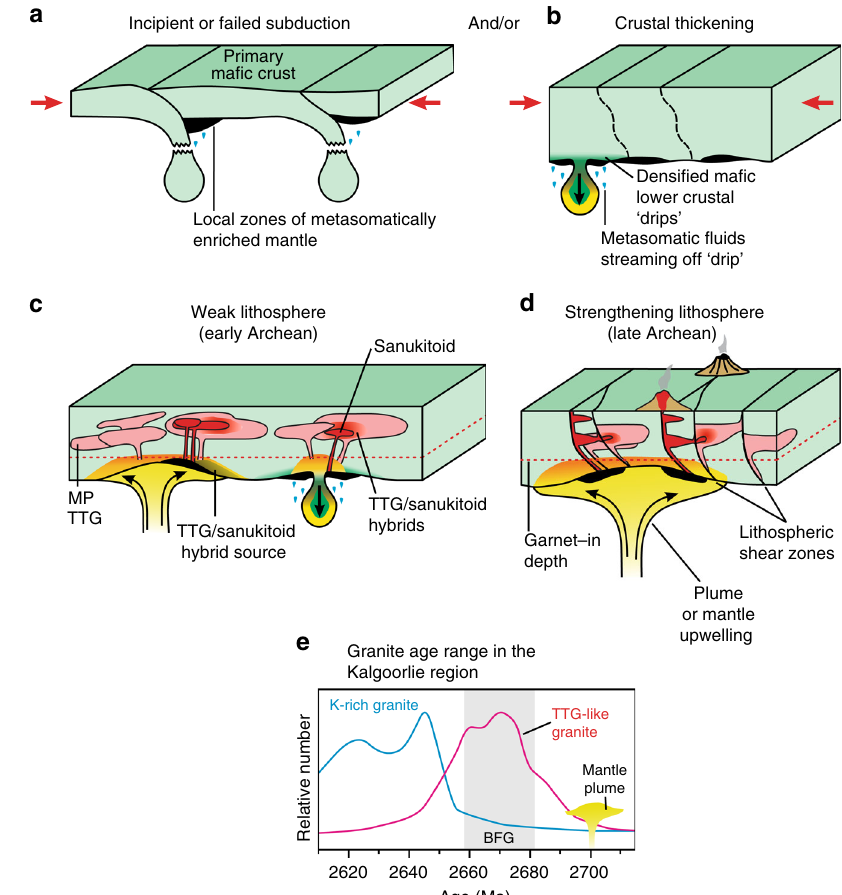
Fig. 10 Schematic model showing the geological environment of TTG and sanukitoid formation. Block diagrams illustrating potential sites of Archean medium pressure (MP) TTG and sanukitoid (including high-pressure (HP) TTG) formation. Pockets of metasomatized lithospheric mantle (MLM) representing the source for sanukitoid form throughout the Archean during incipient, or failed, ma fi c oceanic-plate subduction ( a ) and possibly also after thickening (due to greenstone accumulation and/or crustal shortening) when densi fi ed and gravitationally unstable lower ma fi c crust dripped into the mantle, releasing volatile components ( b ). Melting of primary ma fi c crust below the garnet-in zone (red line), was induced by mantle upwelling. A ductile crust in the early Archean ( c ) meant that sanukitoid melts (red) derived from remnant MLM sources could not effectively ascend and evolve uncontaminated by crust and contemporaneous MP TTG (pink) crustal melts. The development of lithosphere-scale structures in Neoarchean crust ( d ) and possibly an increase in the volume/number of MLM sources during the transition to a global plate tectonic regime, increased both the proportion of sanukitoid magmatism and the ef fi ciency of it rising to higher crustal levels without contamination. Where thermal anomalies were local or weak, only MLM was remobilised and sanukitoid magmatism was unassociated with MP TTG 27 . The Black Flag Group formed in the wake of widespread